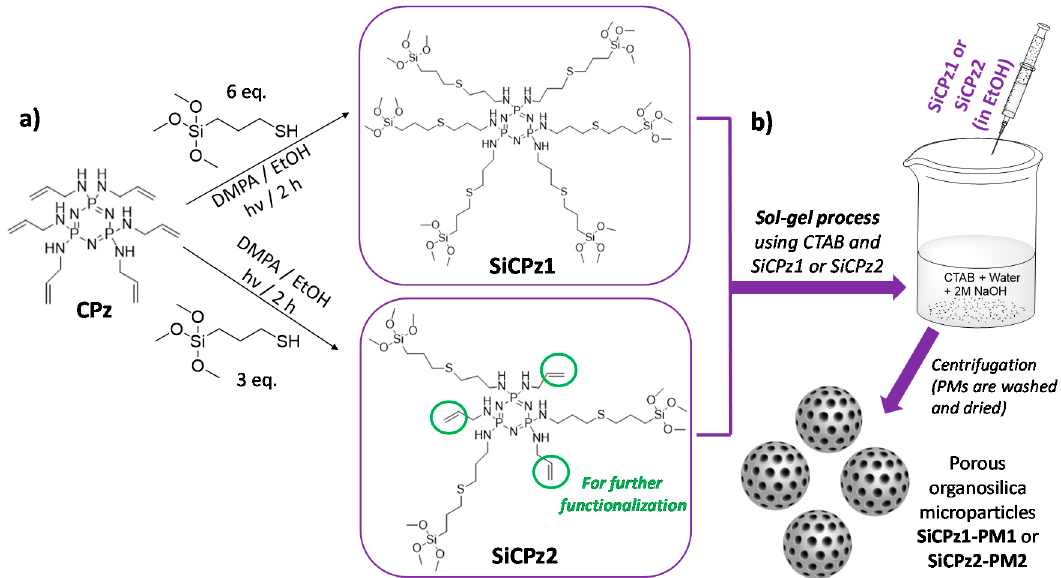
Figure 1. Scheme of ( a ) synthesis of organosilica phosphazene bridges (fully substituted CPz1 precursor yielding to SiCPz1, or half substituted yielding to SiCPz2, able to be further functionalized), both used for the ( b ) preparation of hybrid porous organosilica microparticles (SiCPz1-PM1 and SiCPz2-PM2) following well-known CTAB mediated sol-gel process, collected by centrifugation.